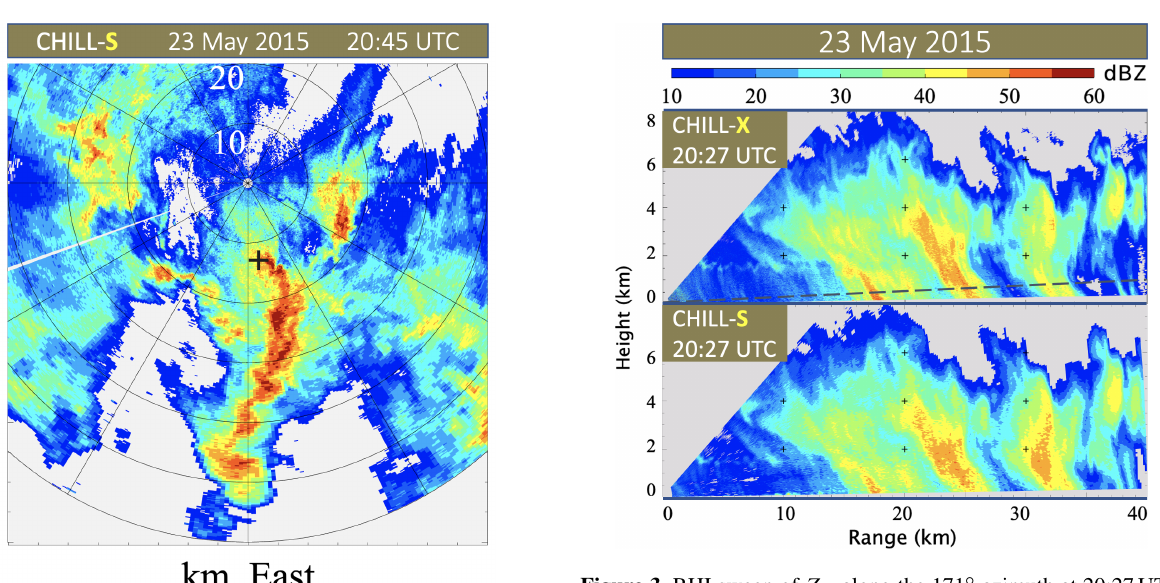
Figure 3. RHI sweep of Z H along the 171 ◦ azimuth at 20:27UTC about 18min before peak echo descended on the Easton instru- mented site at a range of 13km. The “+” marks are at 2km inter- vals. (Top) X-band measured (uncorrected) reflectivity. The range profiles of radar data along the dashed line are shown in Fig. 4. (Bottom) S-band measured